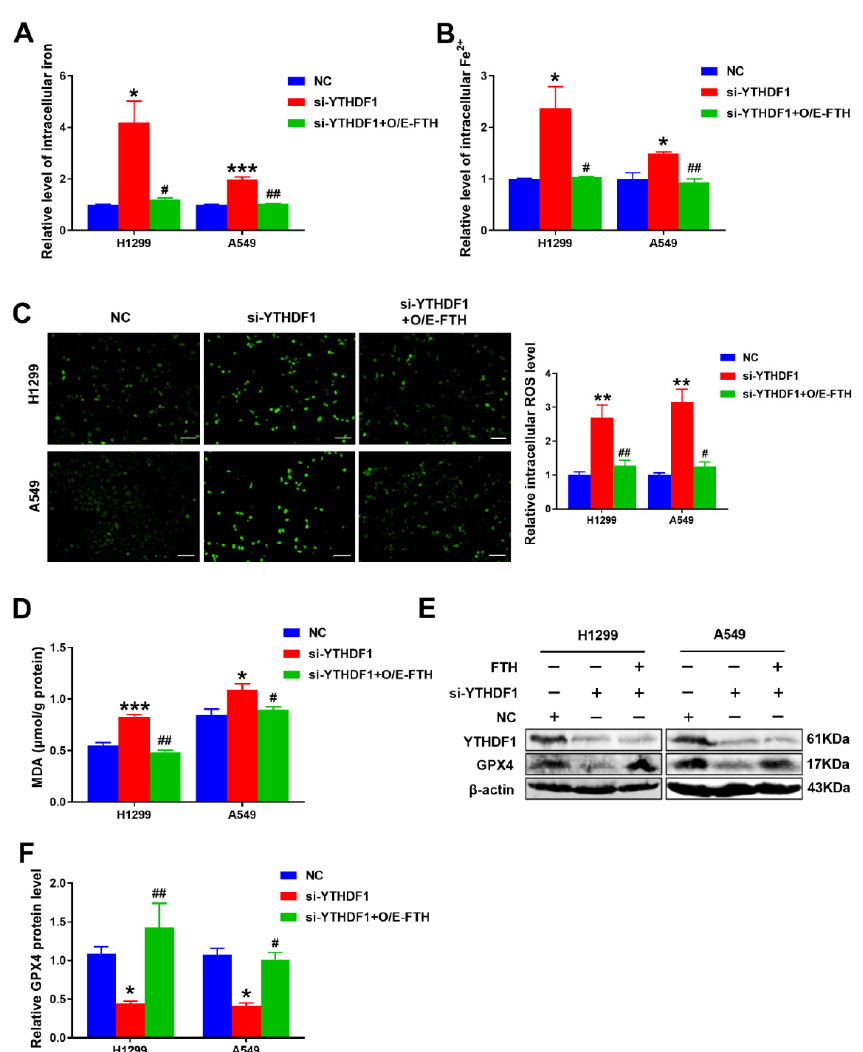
Figure 6. YTHDF1 knockdown induced FTH-mediated ferroptosis. ( A , B ) An intracellular iron assay showed the effect of FTH overexpression on intracellular total iron and Fe2+ levels. ( C ) Intracellular ROS level was measured by DFCH-DA fluorescence with transfection of NC siRNA, YTHDF1 siRNA or overexpressed FTH in H1299 and A549 cells. Scale bar, 100 µ m. ( D ) An MDA assay showed the impact of FTH overexpressed in YTHDF1 knockdown cells. ( E ) The protein level showed by a Western blot of GPX4 upon the YTHDF1 depletion or the FTH overexpression in lung cancer cell lines. ( F ) Statistical analysis for the result of GPX4 protein assays in ( E ). * p < 0.05; ** p < 0.01; *** p < 0.001; # p < 0.05; and ## p <